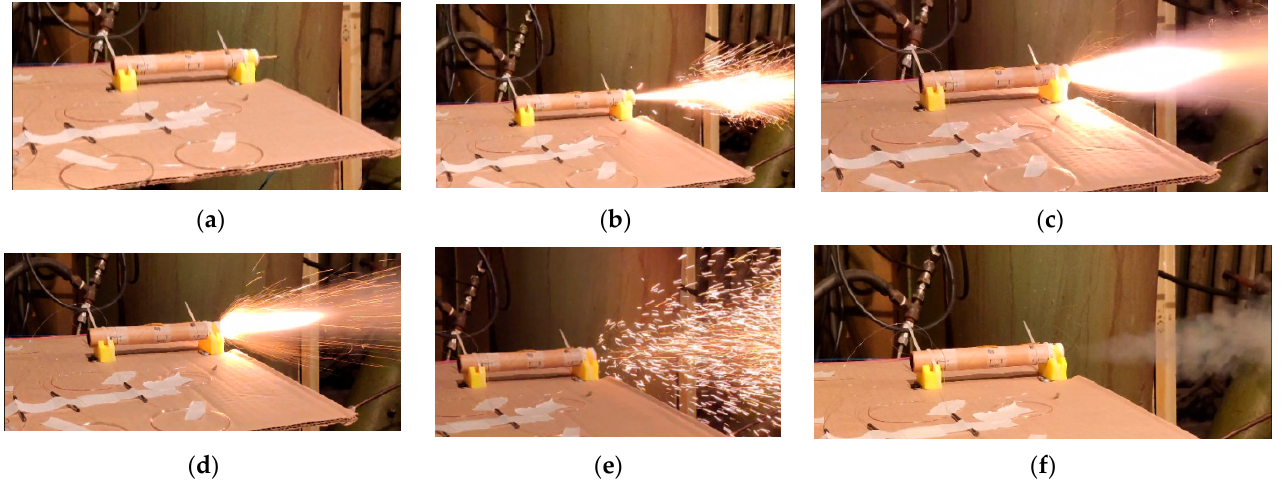
Figure 6. Photos of the experiment: before the beginning ( a ); launch ( b ); nominal mode ( c , d ); engine shutdown and combustion termination ( e , f ).